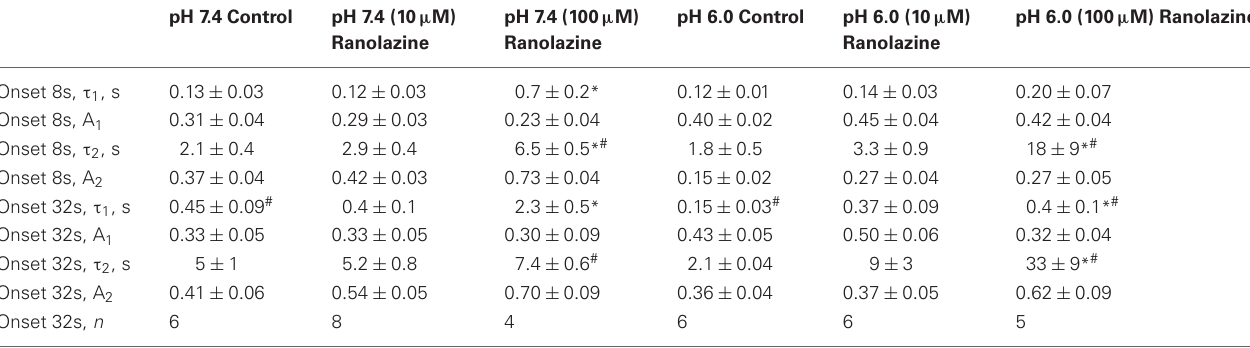
Table A8 | Slow inactivation recovery.